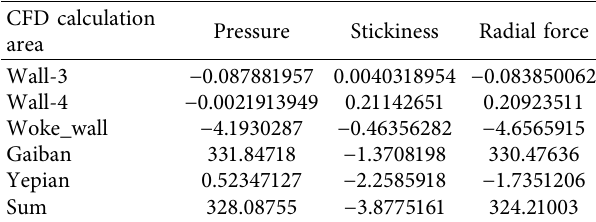
Table 7: Summary of axial force of the plastic centrifugal